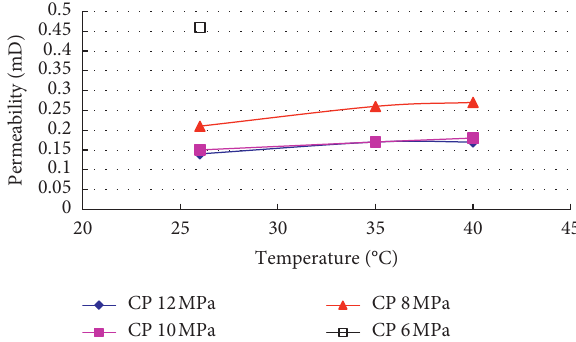
Figure 14: Variation in permeability with increasing temperature at a gas pressure of